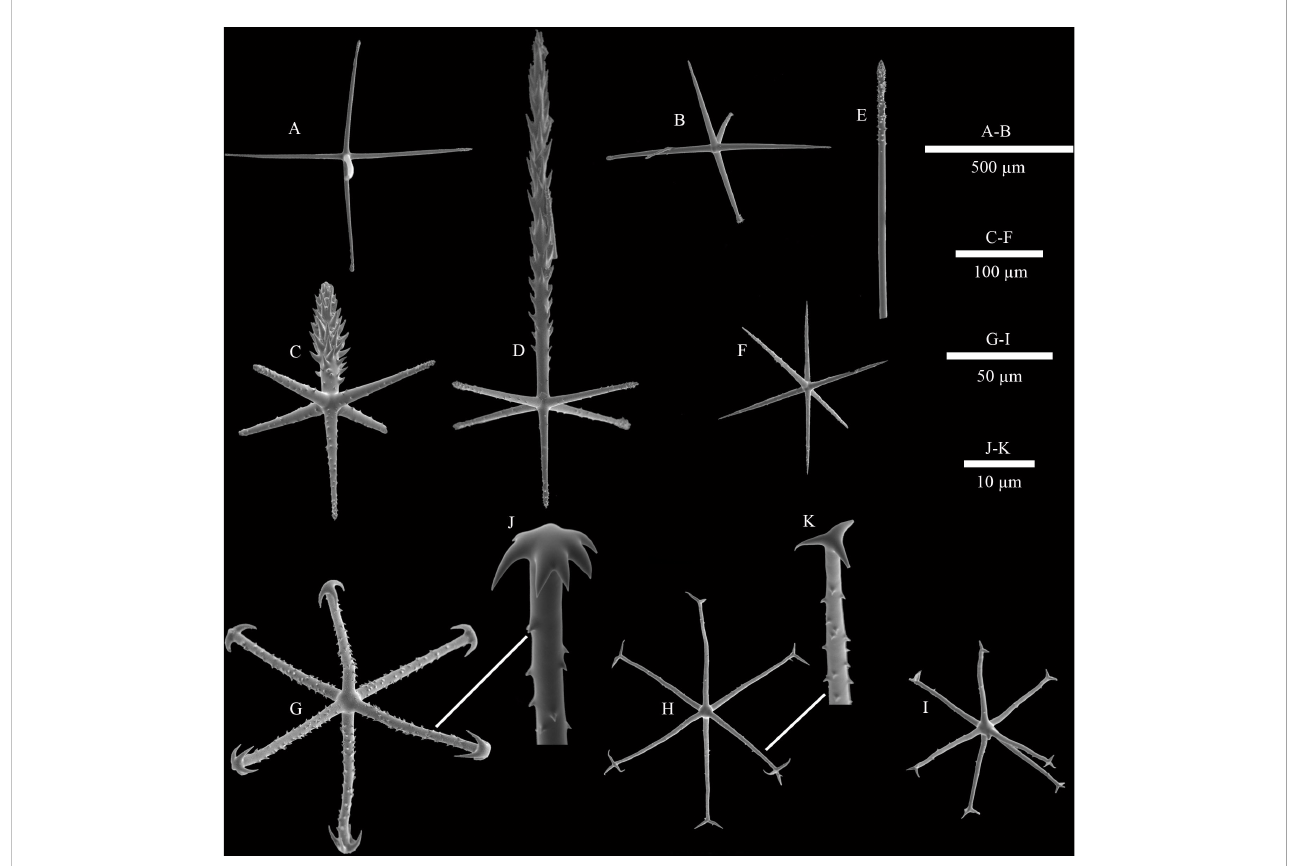
FIGURE 3 SEM images of spicules of Caulophacus ( Caulodiscus ) iocasicus sp. nov. (A) , hypodermal pentactin; (B) , hypoatrial pentactin; (C) , atrial pinular hexactin; (D) , dermal pinular hexactin; (E) , details of the termination of choanosomal diactin; (F) , microhexactin; (G) , discohexactin; (H) , onychohexactin; (I) , hemionychohexaster; (J) , detail of the toothed disc of discohexactin; (K) , detail of the termination of